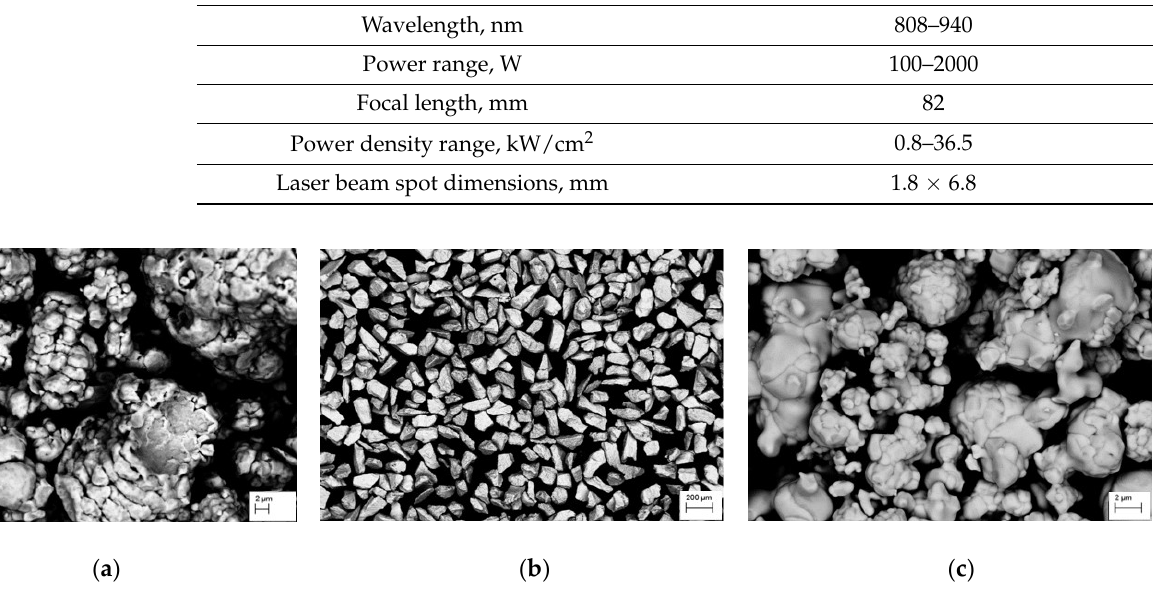
Figure 2. Morphology of powders: ( a ) Ni, ( b ) Cr, and ( c )